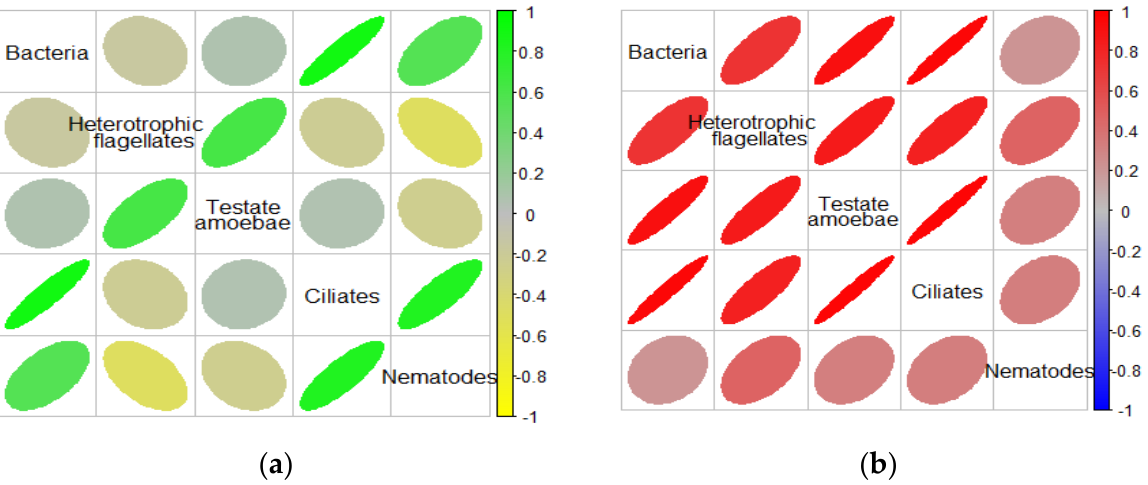
Figure 8. Correlogram between microbial and nematode communities before and ( a , b ) after fire. The ellipse angulation and the colour intensity are proportional to the Pearson correlation coefficient: Positive correlations are drawn in green/red whereas the negative correlations are in yellow/blue.